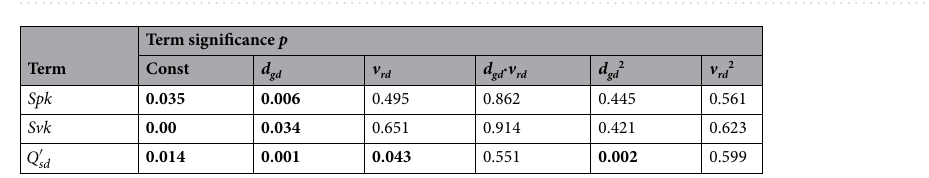
Table 3. Term significance of the conditioning parameters on Spk, Svk and Q significant. Significant values are in